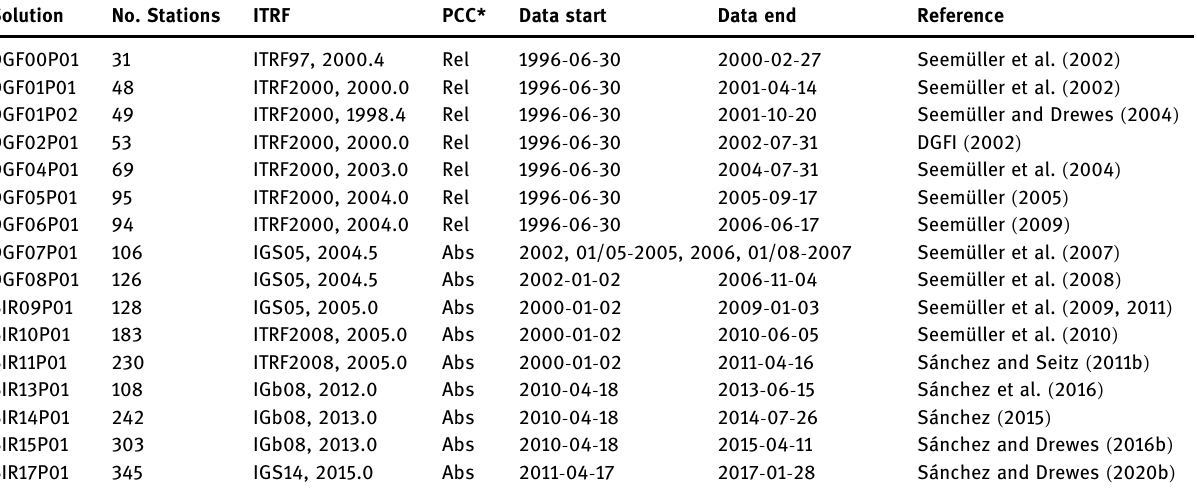
Table 4: SIRGAS reference frame cumulative solutions determined by DGFI – TUM